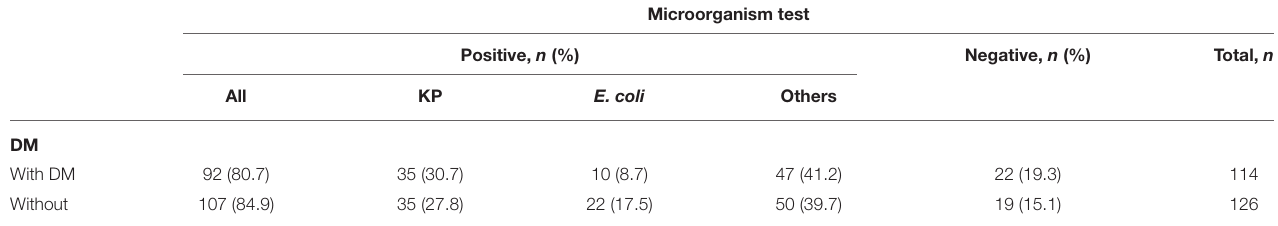
TABLE 6 | Microorganism test results of patients with PLA ( N =